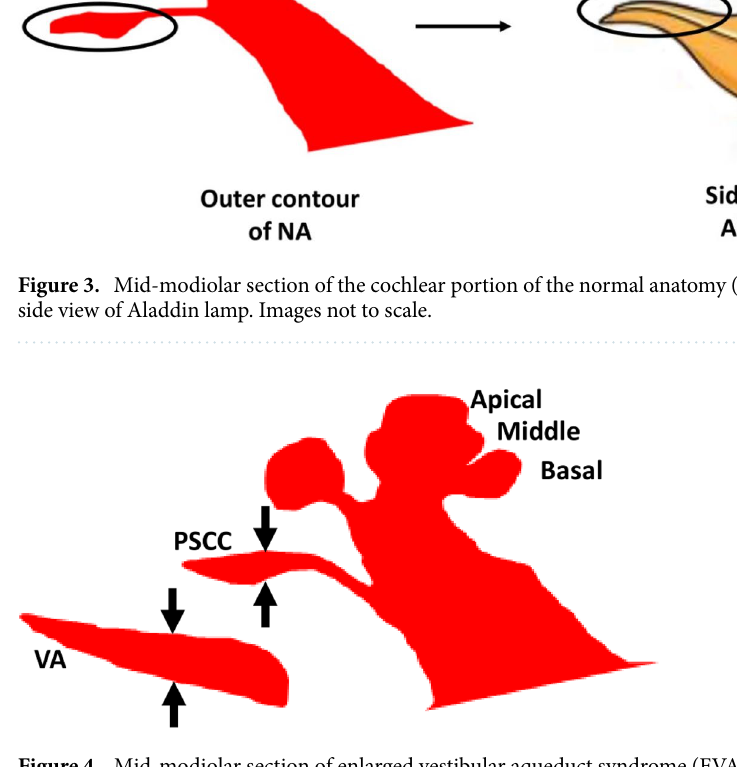
Figure 4. Mid-modiolar section of enlarged vestibular aqueduct syndrome (EVAS) showing the vestibular aqueduct (VA) wider than the width of the posterior semicircular canal (PSCC).